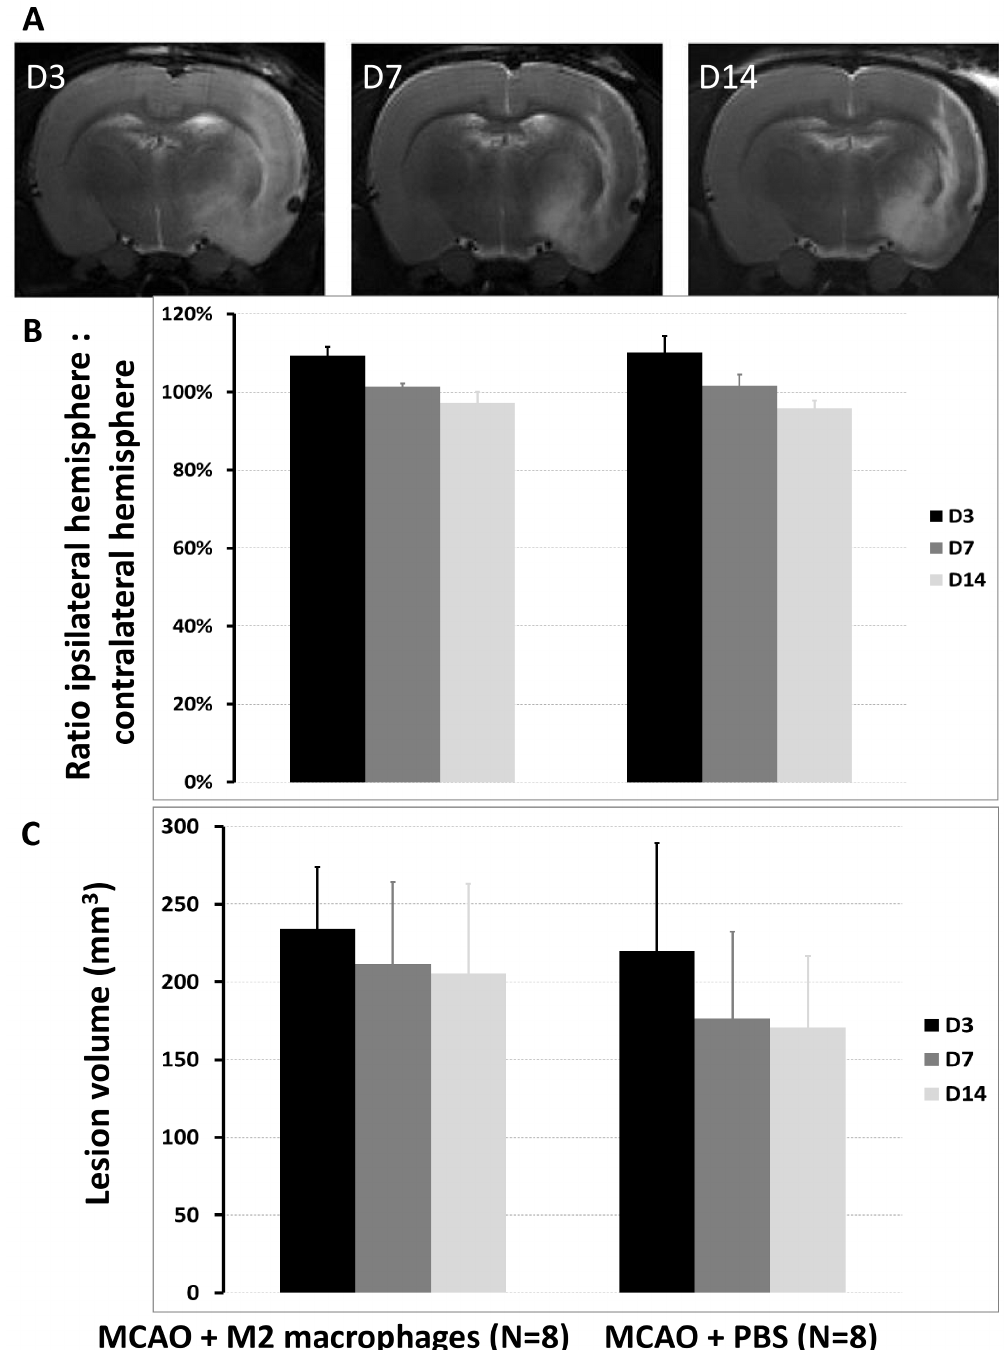
Figure 5. M2 macrophages do not reduce lesion size after ischemic stroke. A- Typical T2-weighted images obtained at D3, D7 and D14 post-ischemia showing the lesion as a hyperintense signal. B- The ratio of hemisphere volumes [ipsilateral:contralateral] showed moderate brain swelling at D3, normalization at D7 and moderate atrophy at D14. No statistically significant difference was seen between treatment groups (analysis of variance for repeated measures, N=8 in each group, p=0.941). C- Before treatment (D3), lesion volume (corrected for brain swelling/atrophy) was not significantly different between groups. Likewise, after treatment (D7 and D14), there was no significant difference between groups (analysis of variance for repeated measures, N=8 in each group,